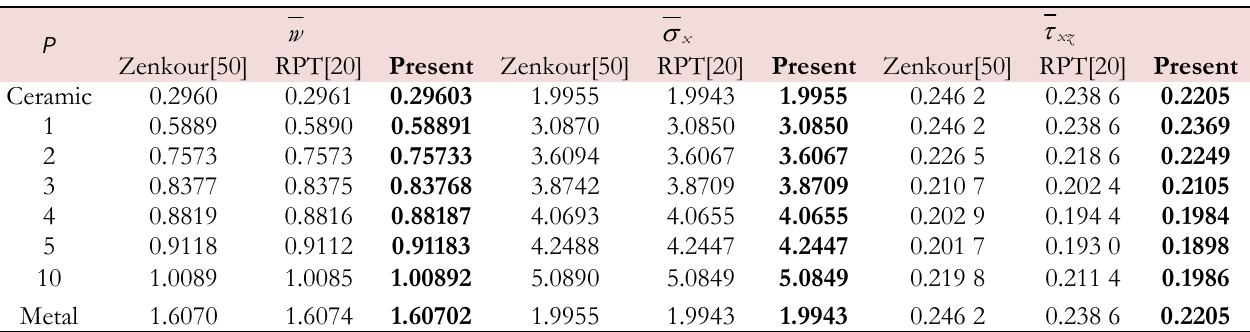
Table 1: Functionally graded plate FG with non-dimensional deflections and stresses on various power law index.